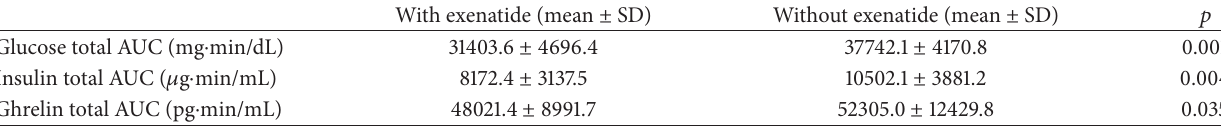
Table 4: Comparison of total AUC values following mixed meal test with and without exenatide